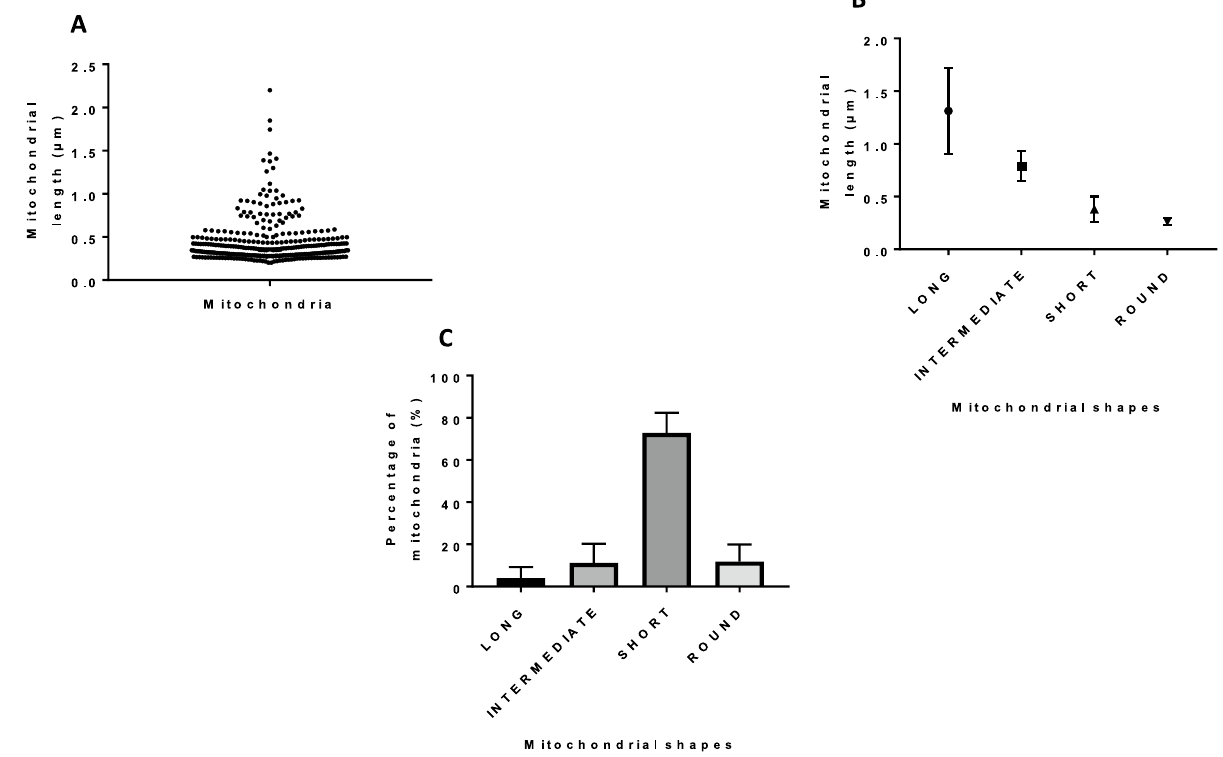
Figure 5. Fiji analysis of scanning electron microscopy micrographs. ( A ) Length distribution of all measured mitochondria. ( B ) Classification of mitochondrial shapes from 16 cells. ( C ) Percentage of each mitochondrial shape (n = 3, mean ±